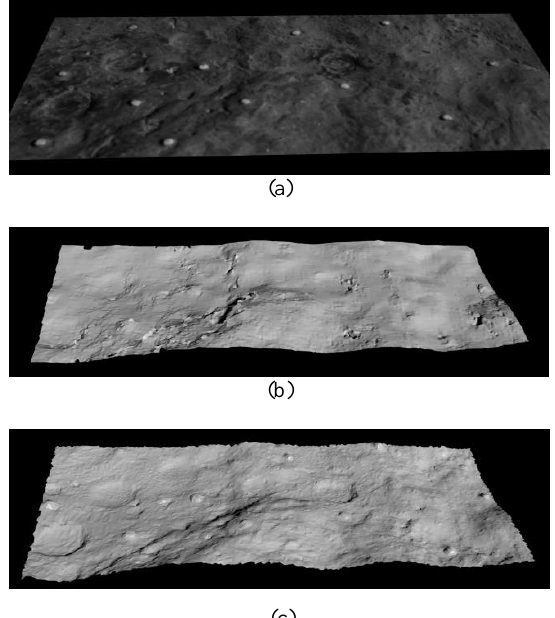
Figure 7 In the top panel (a) we show the Image obtained by one STC channel of a stone target. In the middle panel (b) the DTM, generated by the pipeline is shown and in the bottom panel the DTM generated by the Laser scanner (c).